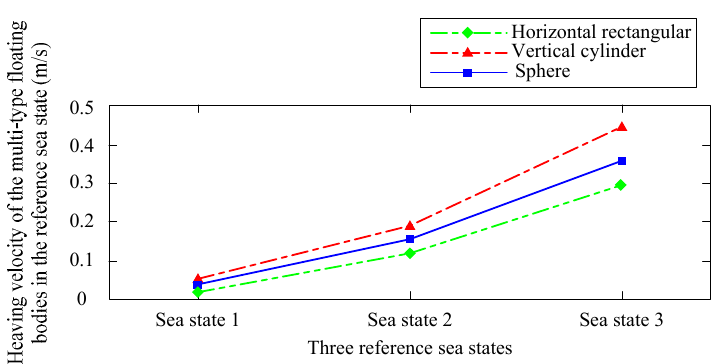
Figure 8. The wave forces of the multi-type floating bodies in the reference sea state.